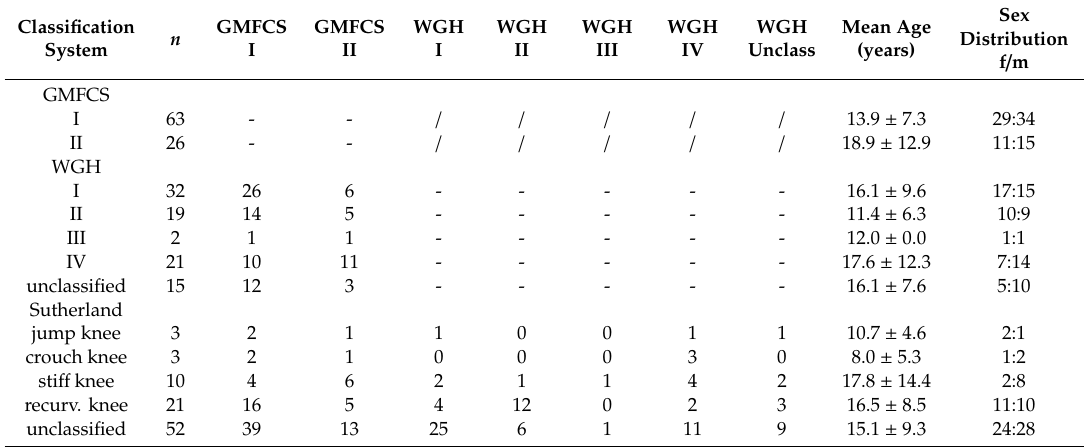
Figure 3. Percentage distribution of the different morphologic subgroups within Gross Motor Function Classification System (GMFCS) levels. Table 1. Prevalence of all gait disorders in association with each other ( n = 89).